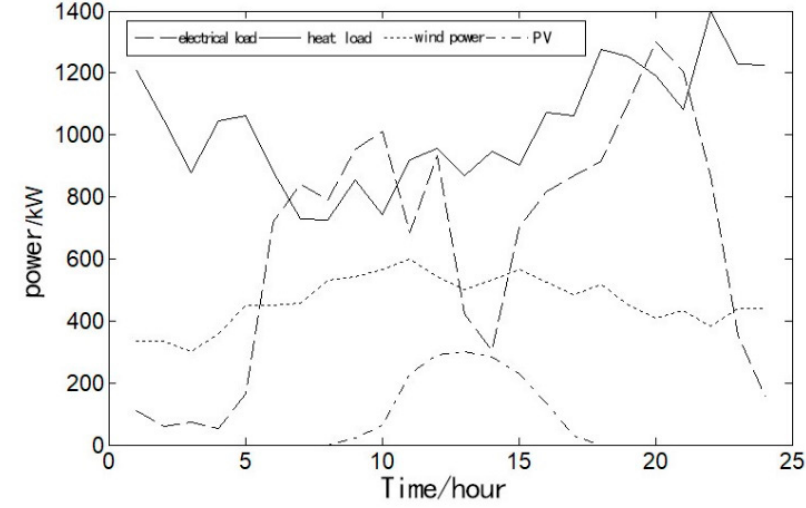
Figure 2. Wind power output, photovoltaic power output, and power curve of electric load and heat load on a typical winter operating day.